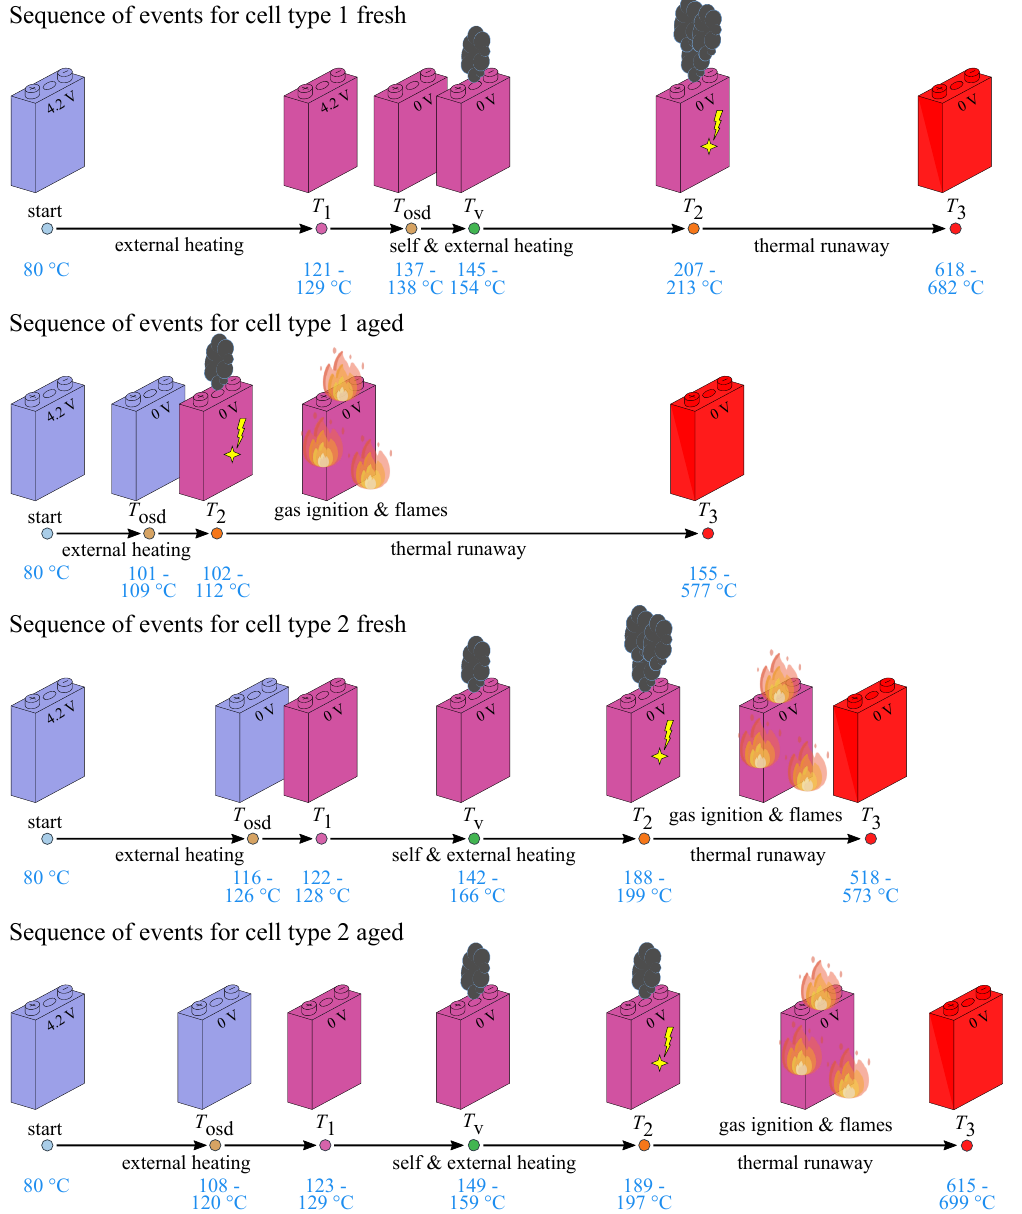
Figure 6. Sketch of the sequence of events during overtemperature tests with increasing surface temperatures for fresh and aged type 1 and 2